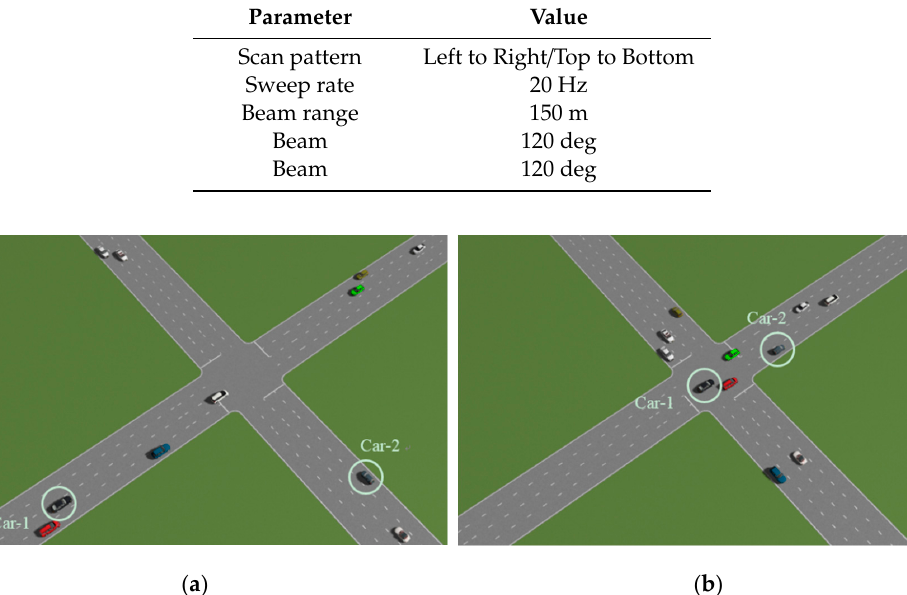
( b ) Figure 8. Illustration of observations. ( a ) Measurements and trajectory observed by Car-1; ( b ) Measurements observed by Car-2.